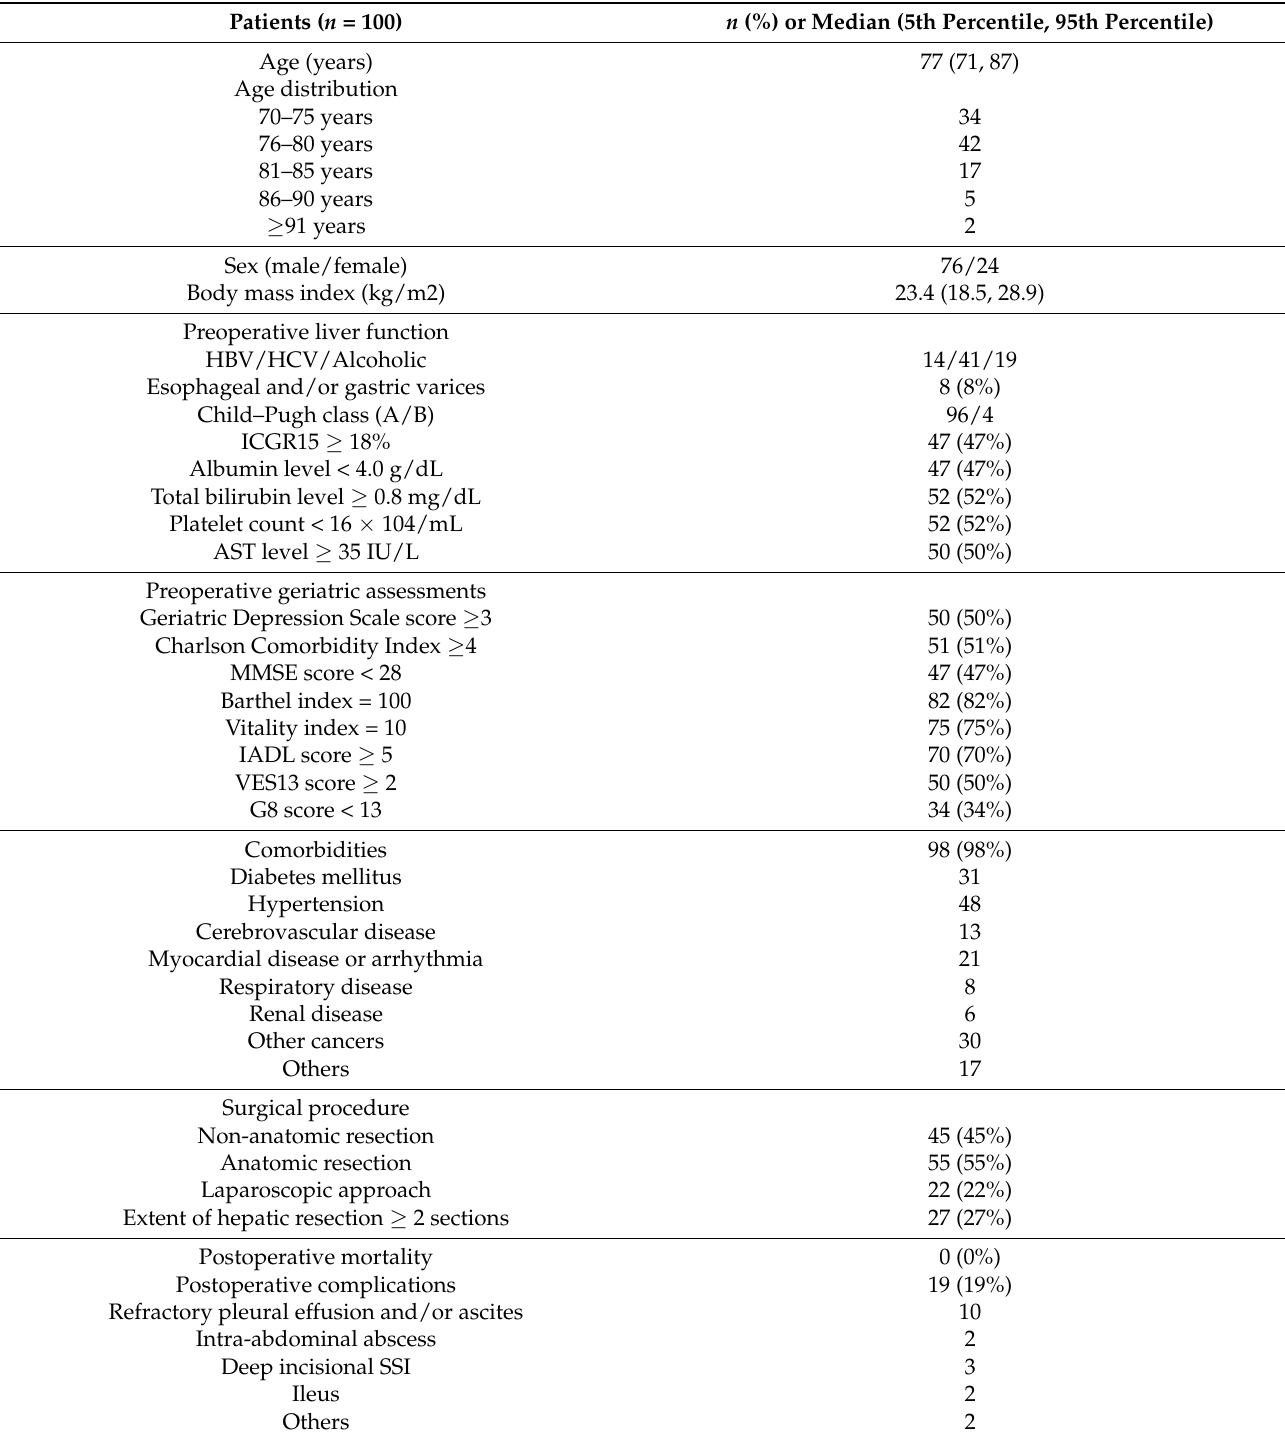
Table 1. Perioperative characteristics of 100 patients aged ≥ 70 years who underwent hepatic resection for treatment of hepatocellular